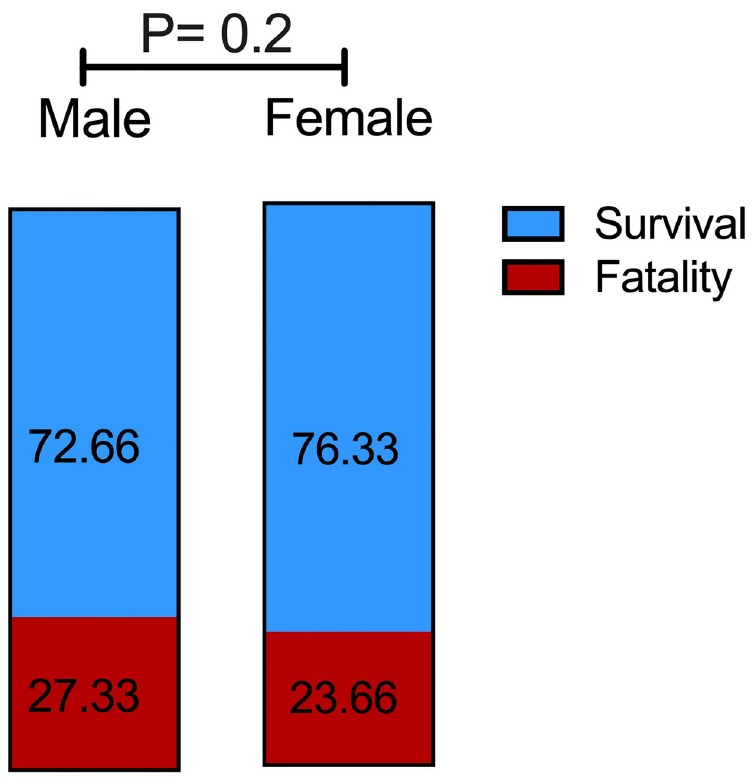
Fig 1. Histograms showing the percentage of fatality in male and female admitted to the ICU. P < 0.02 was determined using the Chi-Square test.